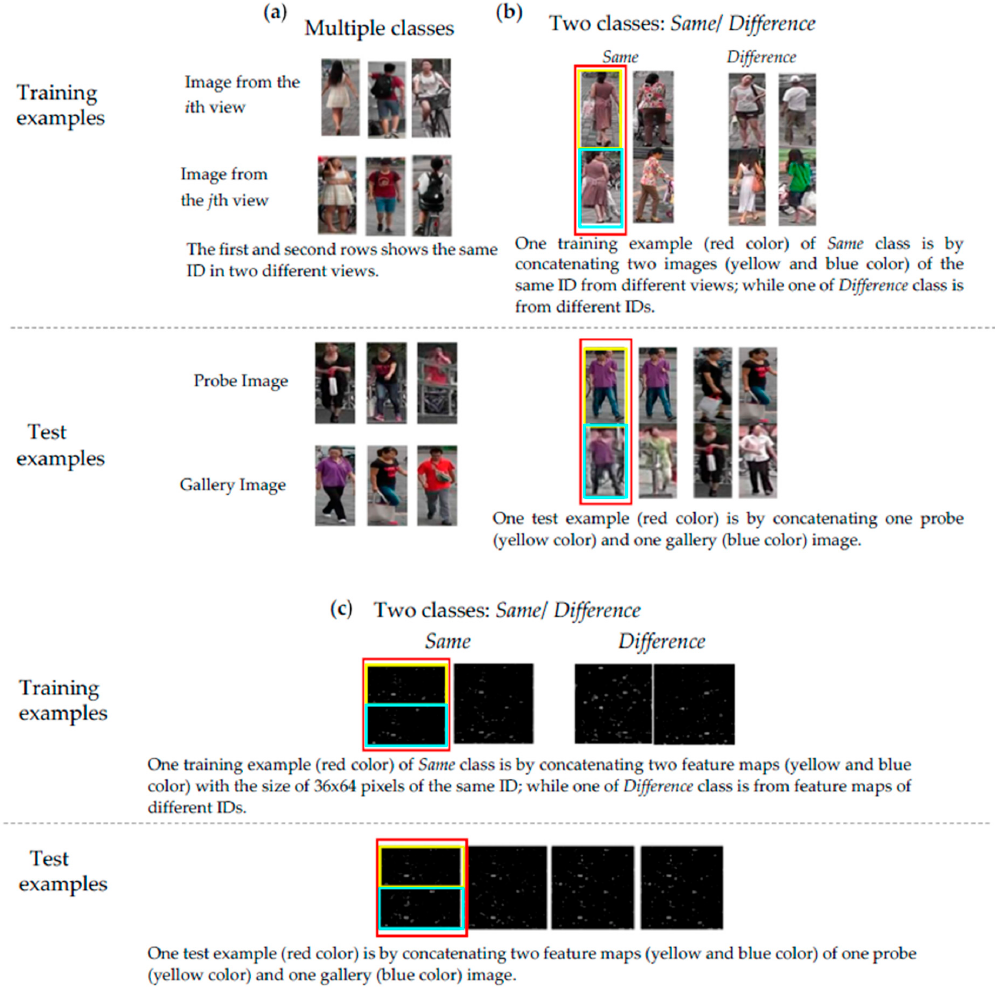
Figure 6. Training and test examples in ( a ) Experiment 1, ( b ) Experiment 2 and ( c ) Experiment 3. Table 3. Detection results with di ff erent IOU